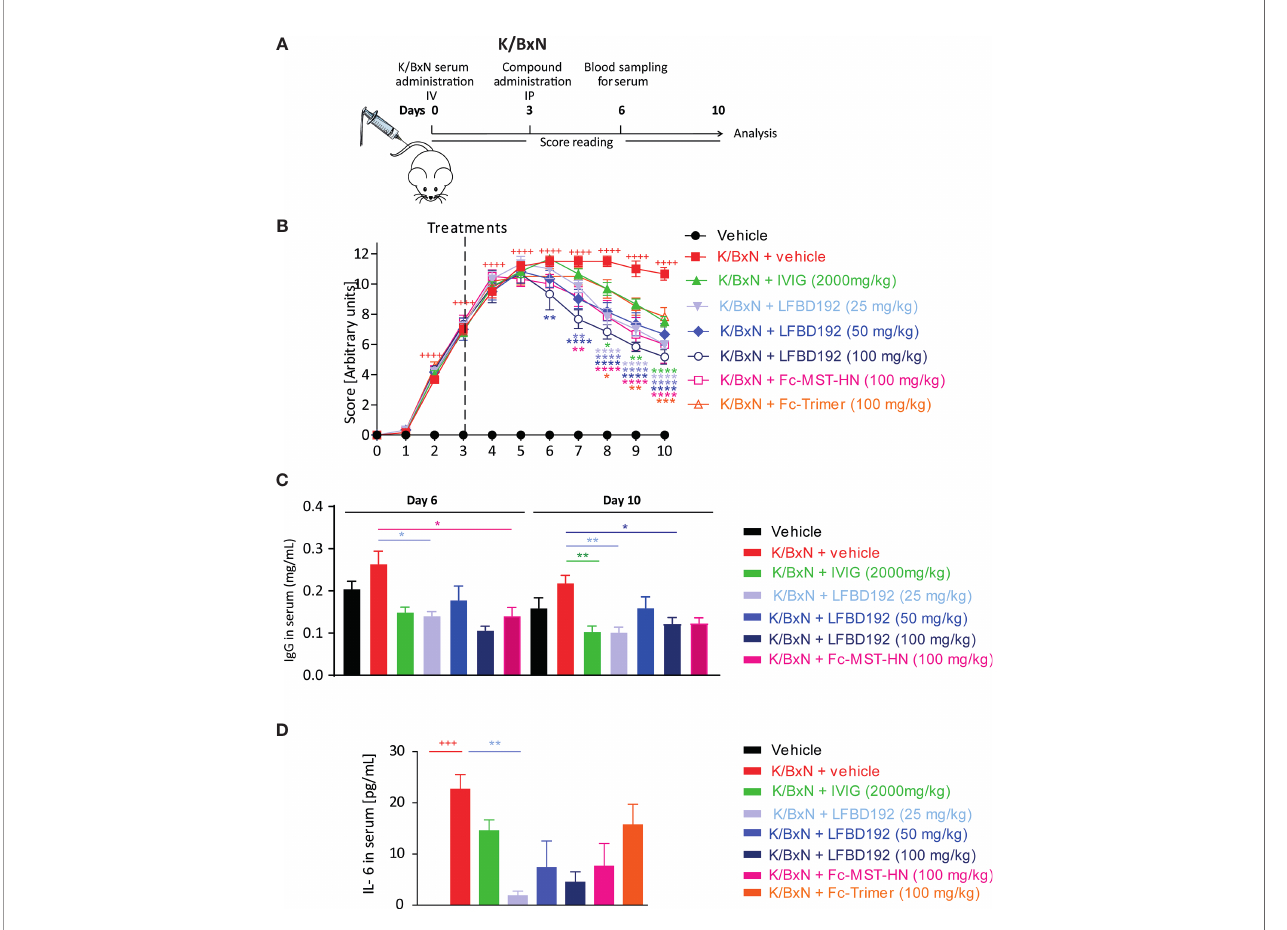
FIGURE 7 | LFBD192 ameliorated disease activity in a K/BxN-induced mouse model of acute arthritis. (A) Schematic representation of the mouse K/BxN model with administration of the compound 3 days after K/BxN serum injection. (B) Clinical scores after treatment with PBS, IVIg (2,000 mg/kg), LFBD192 (25, 50, and 100 mg/kg), Fc-MST-HN (100 mg/kg), and the Fc-trimer (100 mg/kg). (C) Serum IgG levels were reduced at days 6 and 10 in LFBD192-treated mice compared with mice treated with PBS. Bars represent mean serum IgG levels ± SEM ( N =6 mice per group). This result is representative of at least two experiments. (D) The levels of systemic IL-6 were reduced at day 6 in LFBD192-treated mice. Bars represent mean serum IL-6 levels ± SEM ( N =6 mice per group). This result is representative of at least two experiments. Statistical evaluation of the differences among experimental groups was performed by two-way ANOVA followed by Dunnett ’ s post-test. P -values <0.05 were considered signi fi cant. +++ p <0.001, ++++ p <0.0001: vehicle vs K/BxN + vehicle; * p <0.05, ** p <0.01, *** p <0.001, **** p <0.0001: compared with K/ BxN + vehicle. All statistical analyses were performed using GraphPad Prism, version 8 for Windows (GraphPad Software Inc., San Diego, CA,